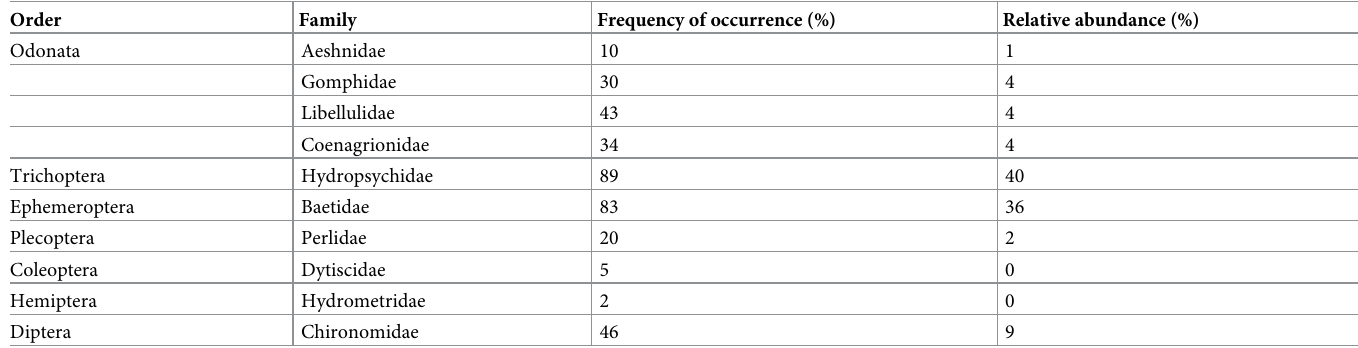
Table 2. Potential macroinvertebrate predators of blackfly larvae collected from streams in the Omo Gibe river basin, southwest Ethiopia.